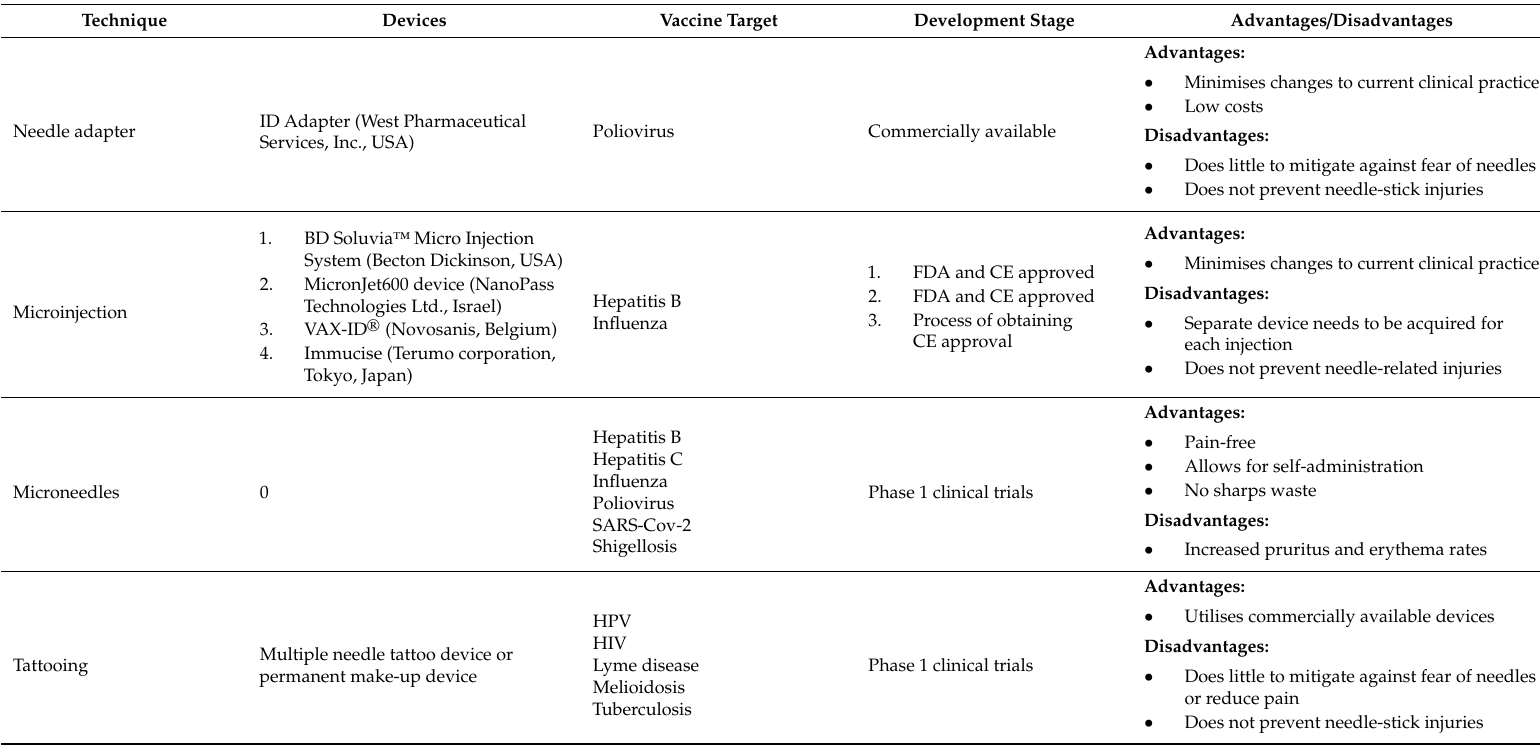
Table 1. An overview of di ff erent vaccination techniques for the dermal compartment, the device developed, and the vaccination targets investigated. Their current developmental stage and advantages and disadvantages are